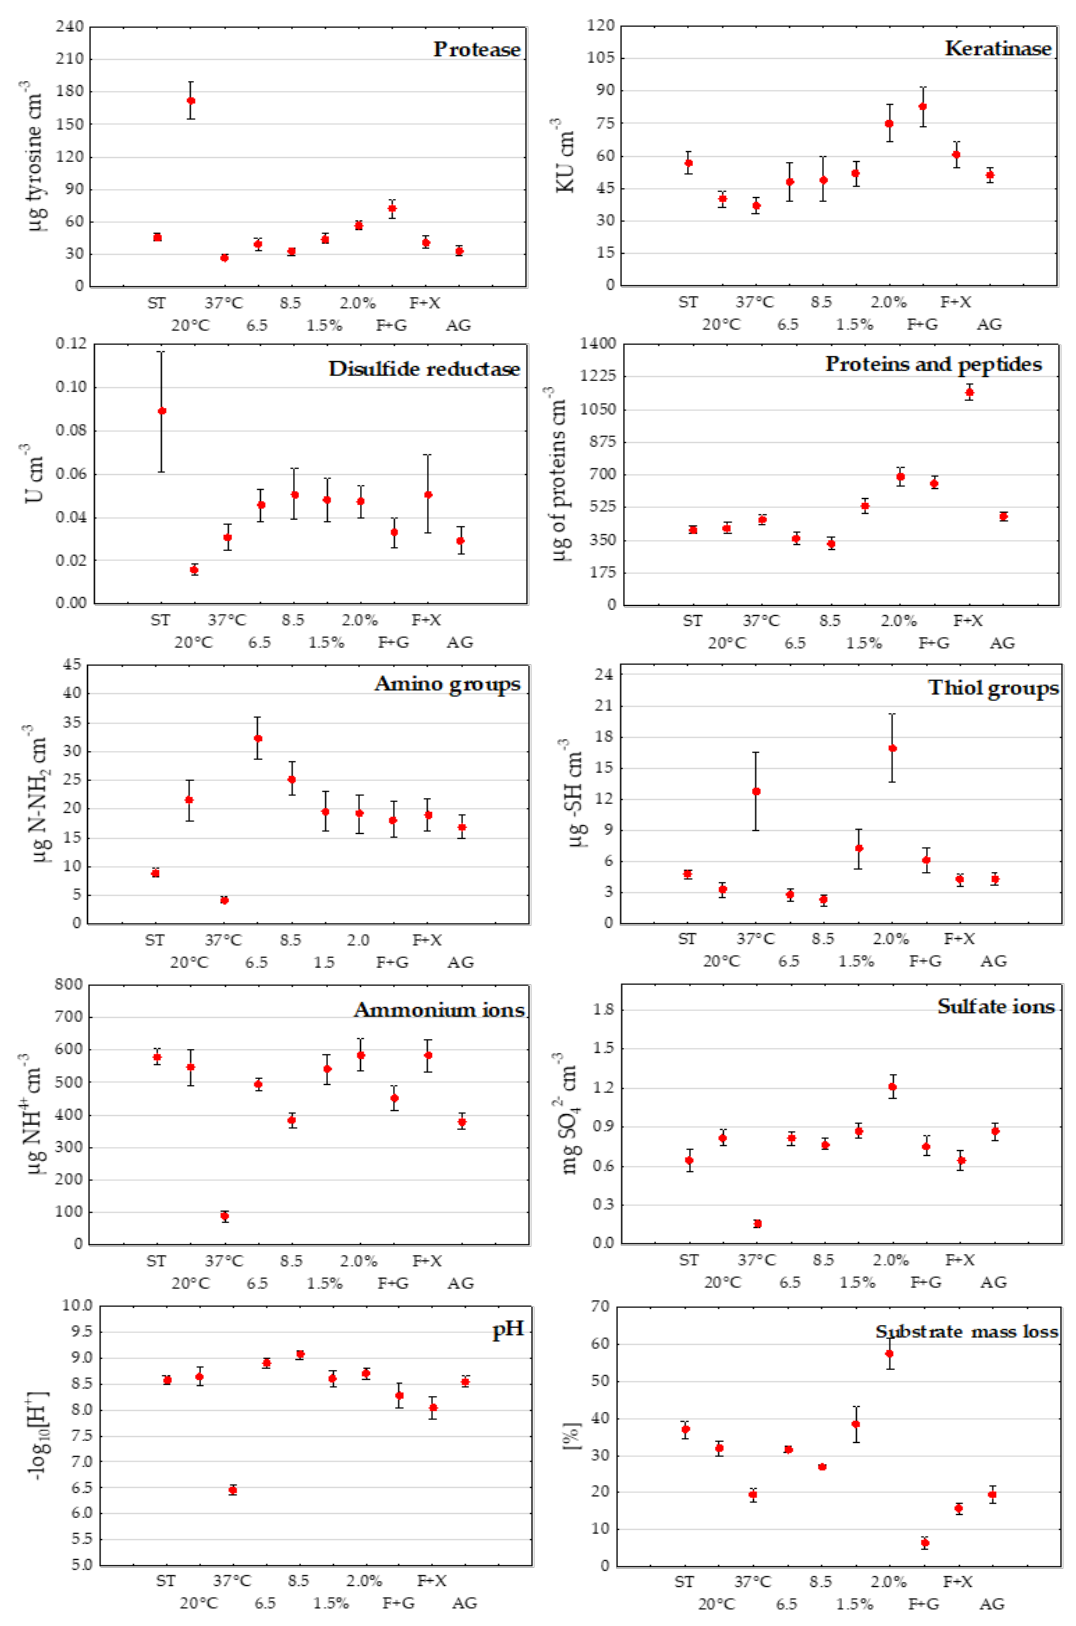
Figure 7. Summary of significant differences within the analyzed cultivation conditions of Trichophyton ajelloi ; α = 0.05.